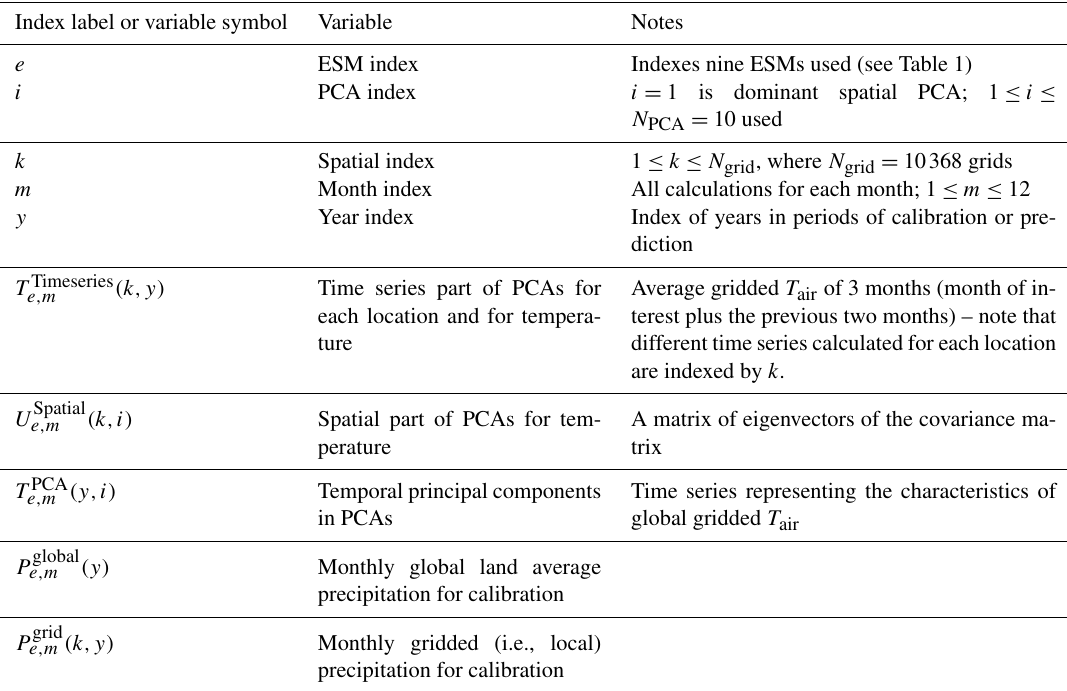
Table 2. List of index labels and variable symbols in the